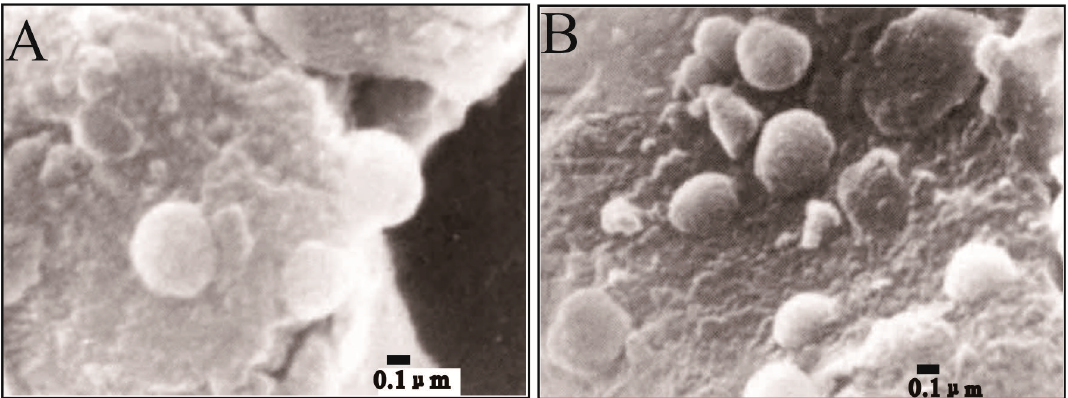
Figure 4. SEM images of dolomite with high iron content in microbial culture experiments [37]. Both ( A ) and ( B ) are illustrating nanocrystals of the ferroan dolomite mediated by subpherical nanobacteria on the surface of the substrate.